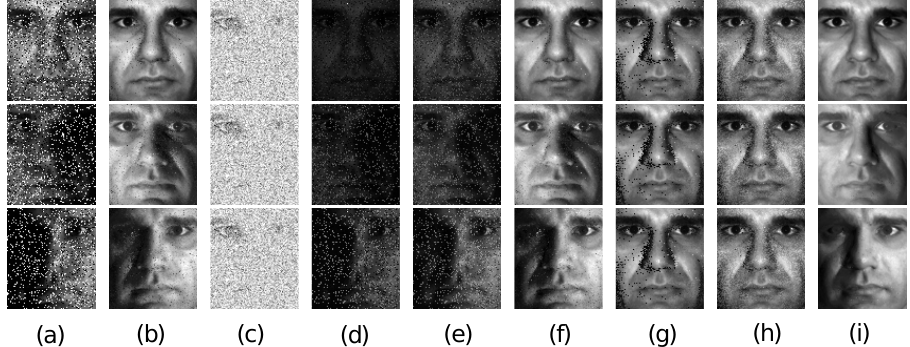
Figure 12. Removing noise, shadows and specularities from face images. ( a ) Cropped and aligned images from the Extended Yale B database of a person’s face under different illumination. The size of each image is 96 × 84 pixels, and 20 different illumination settings in total were used for the person. We also added salt and pepper noise to each image. Low-rank term X obtained by RPCA ( b ), LR-MDL ( c ), CoGEnT ( d ), BSGFL ( e ), PSSV ( f ), ROUTE ( g ), FGSR ( h ) and the proposed approach ( i